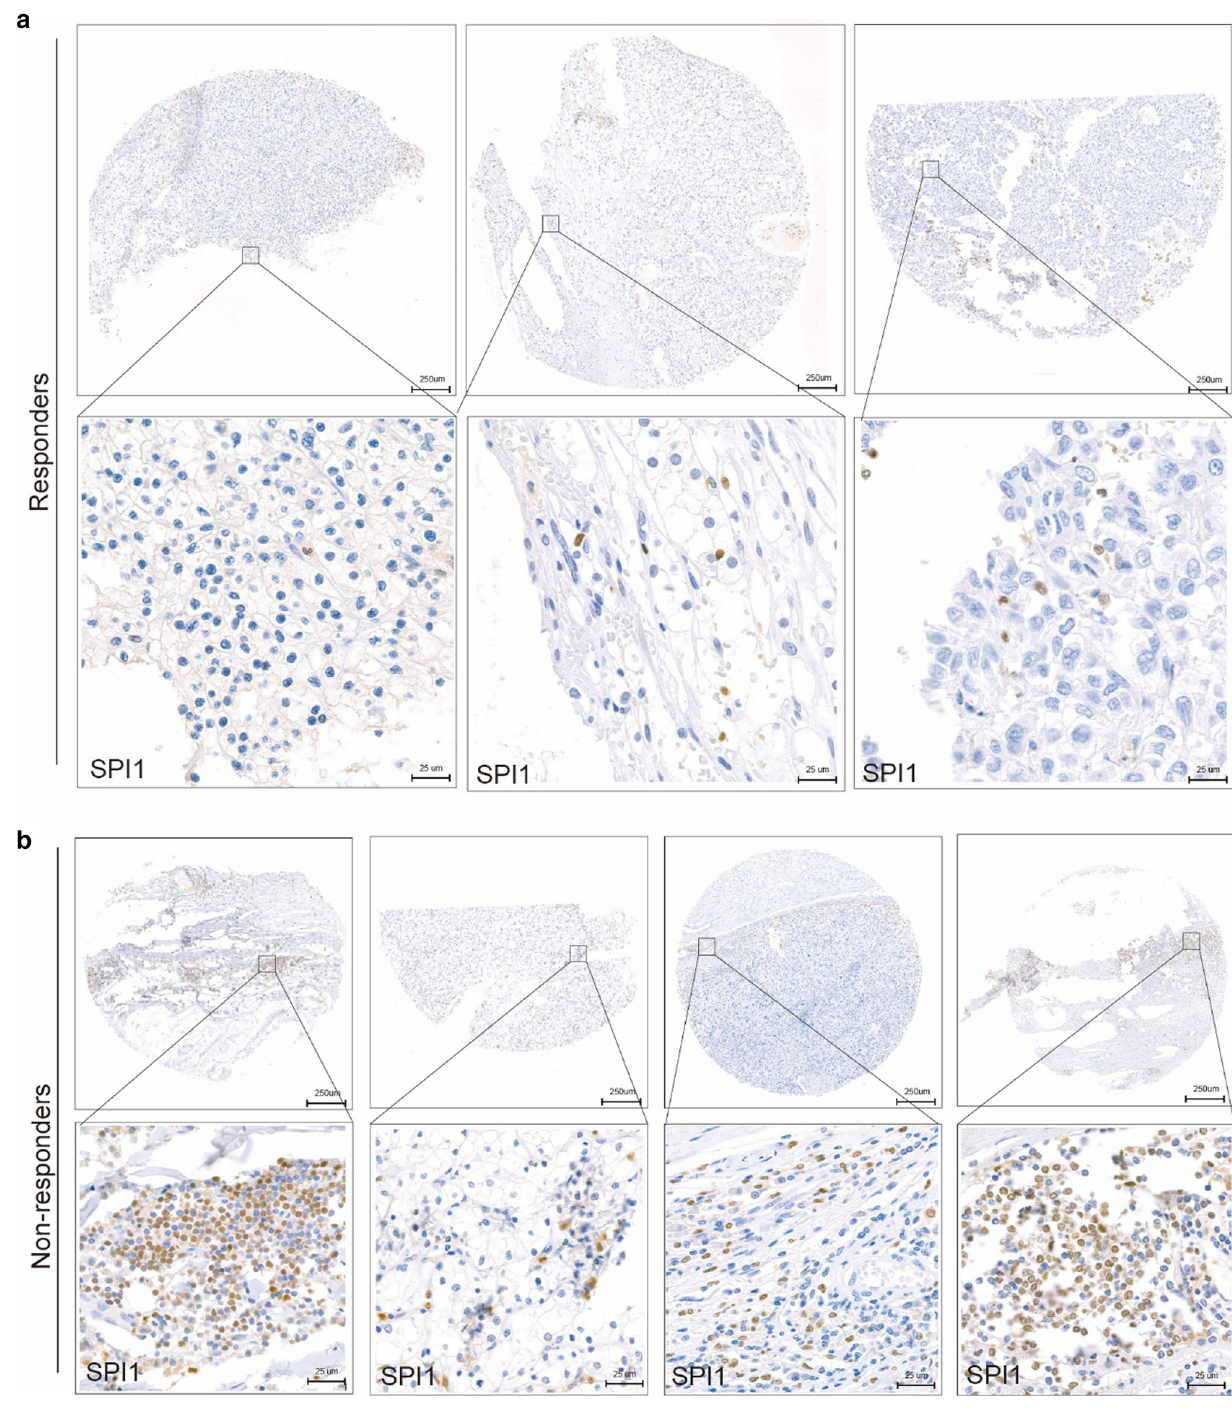
Fig. 5 Relationship between SPI1 expression and immunotherapy efficacy. a SPI1 expression in three responders receiving immunotherapy. b SPI1 expression in four non-responders receiving immunotherapy. Responders included patients with complete disease and partial dis- ease, and non-responders included patients with progressive disease and stable